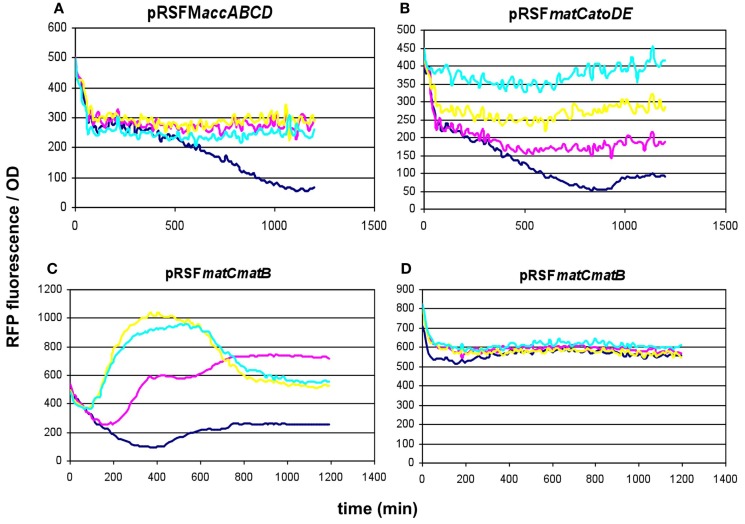
Fluorescence response of BL21DE3 cells carrying pCFR sensor plasmid and (A) pRSFMaccABCD or (B) pRSFmatCatoDA. (C,D) show two distinct fluorescence responses to IPTG induction of cells carrying pRSFmatCmatB. Na-malonate was included in the medium for (B–D). Colors indicate the concentration of IPTG used for induction: dark blue: 0.01 mM; magenta: 0.1 mM; yellow: 1 mM; cyan: 10 mM.